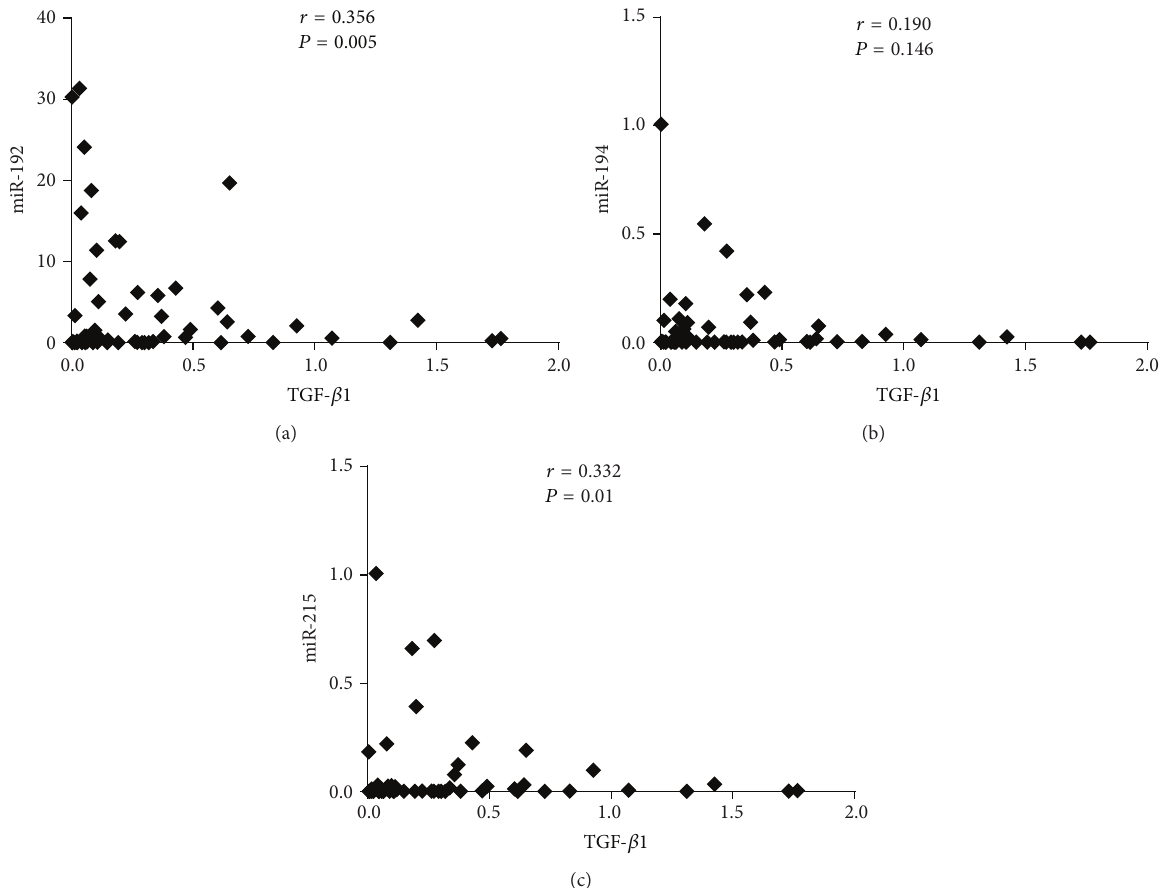
Figure 4: Urinary EV TGF- 𝛽 1 expression and correlations with miRNAs. TGF- 𝛽 1 levels were normalized to GAPDH and were calculated using the 2 −Δ CT method. (a–c) Correlation plots between miRNAs levels and TGF- 𝛽 1 levels. miR-192 significantly correlated with TGF- 𝛽 1 in urinary EVs. Data were compared by Spearman’s rank order correlations ( 𝑃 < 0.05